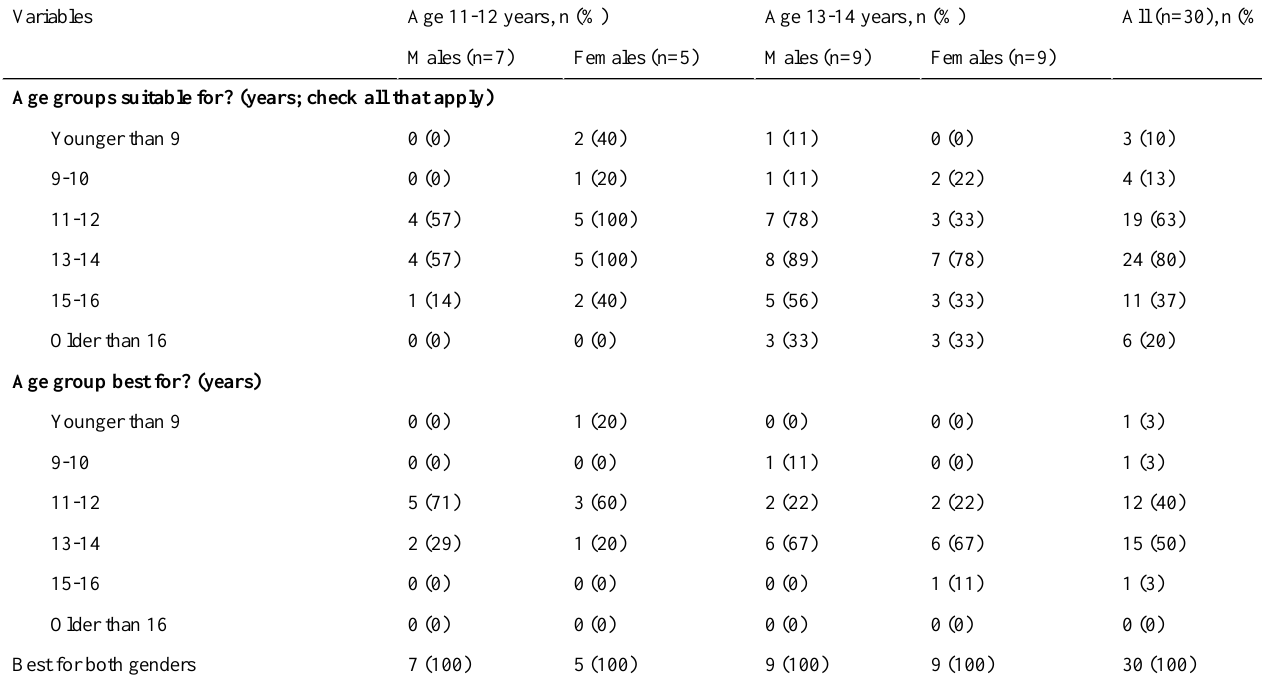
Table 3. Frequency and percentage of participant responses to questions on relevance of game by gender.